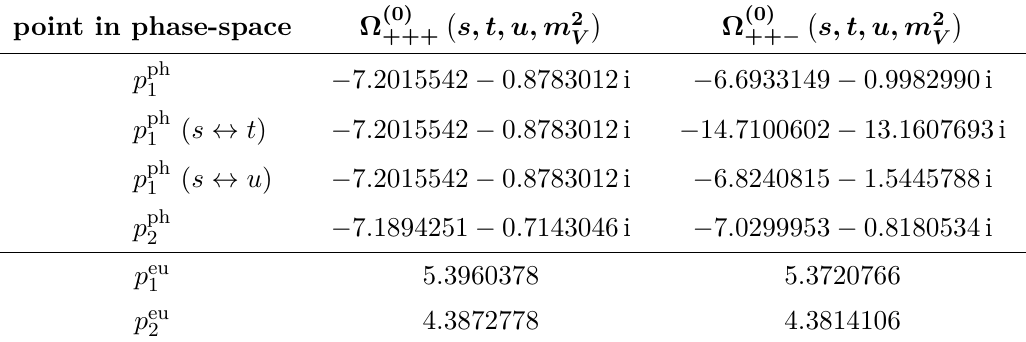
Table 2. Numerical values for the two helicity amplitudes in the Euclidean and in the physical region, at the points defined in eqs. (5.6) and